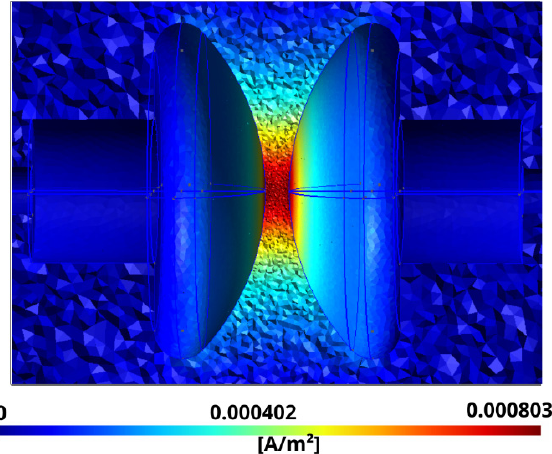
→ J f corresponding to